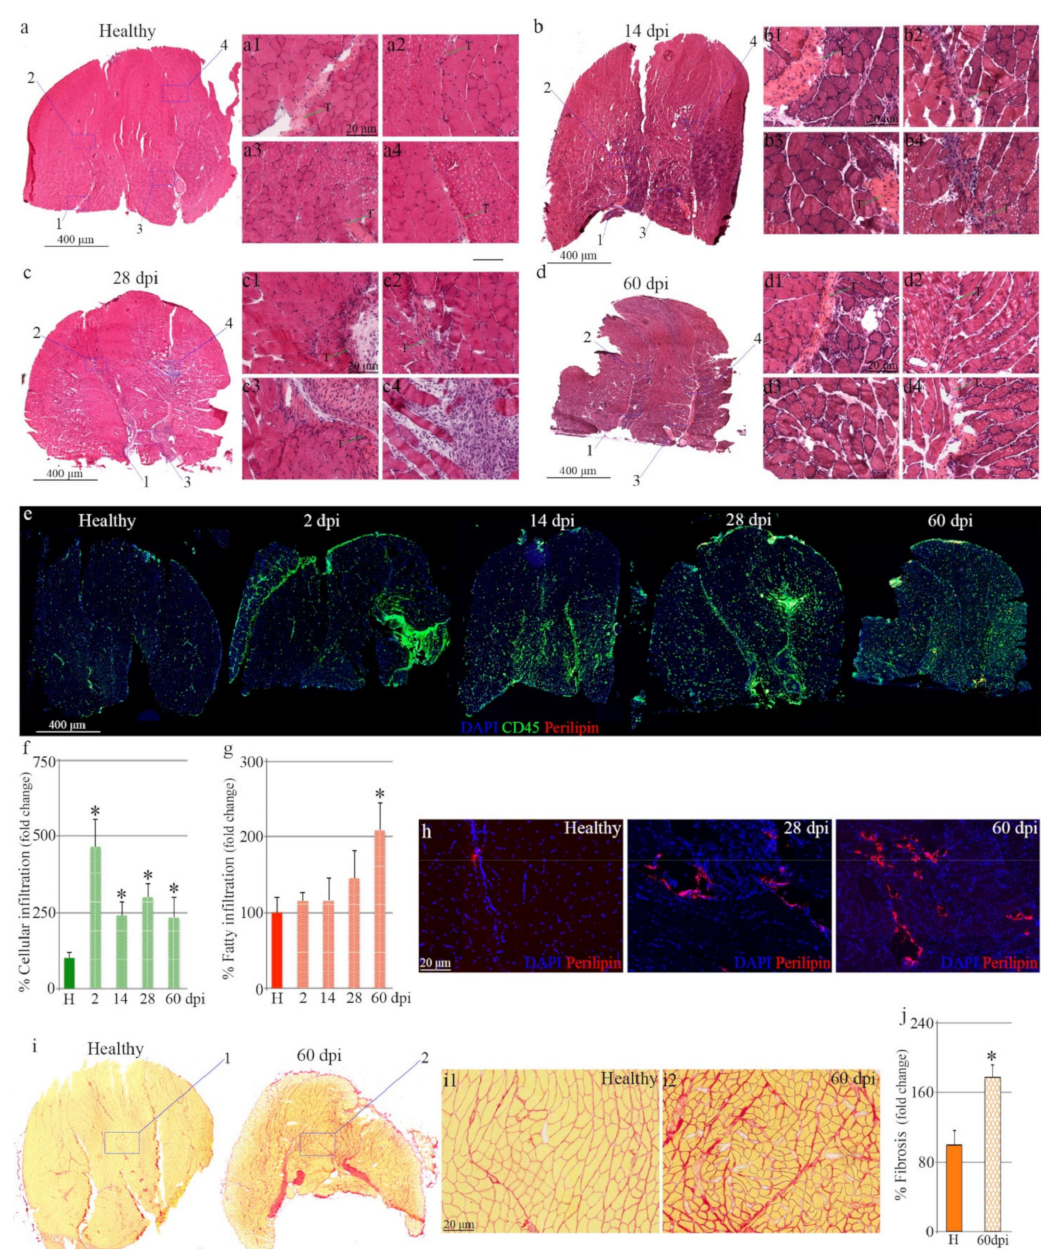
Figure 2. Characterization of damage in the gastrocnemius after complete tendon rupture. ( a ) Repre- sentative muscle tissue sections of healthy and injured hind limbs stained for H&E with ( a1 – d4 ; T) inserts highlighting muscle microstructure in areas closer to tendon insertion. Representative images of skeletal muscles immunostained for ( e ) CD45/perilipin and ( h ) higher magnification of specific areas positive for perilipin. Graphs show the percentage of ( f ) immune cells and( g ) fatty infiltration localized in muscles of control and injured tendons. ( i ) Picrosirius red staining of muscle cryosections and ( i1 , 2 ) inserts pointing to areas of higher magnification. ( j ) Graph showing the percentage of connective tissue accumulation in muscles from healthy or injured limbs. DAPI was used to identify all nuclei. Bars in f, g and j show the mean ± SEM of at least three independent experiments ( n = 3, 2 dpi; n = 6, 14 dpi; n = 6, 28 dpi; n = 6, 60 dpi). * designates significance between healthy and injured experimental groups. dpi, days post-injury; H,